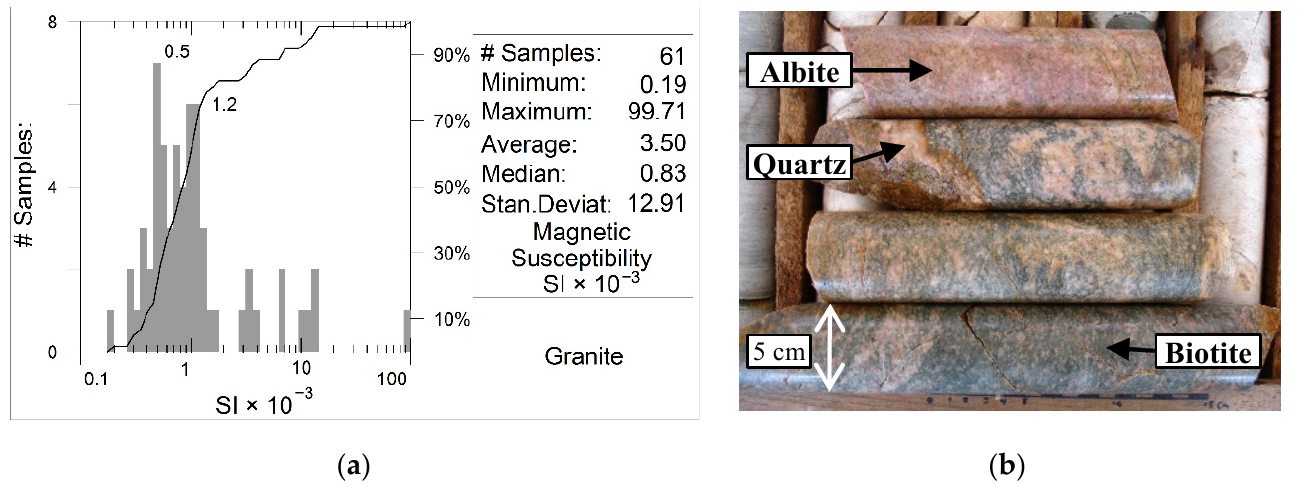
Figure A2. Granite. ( a ) Statistics and histograms of the magnetic susceptibility measurements. ( b ) Core samples picture.